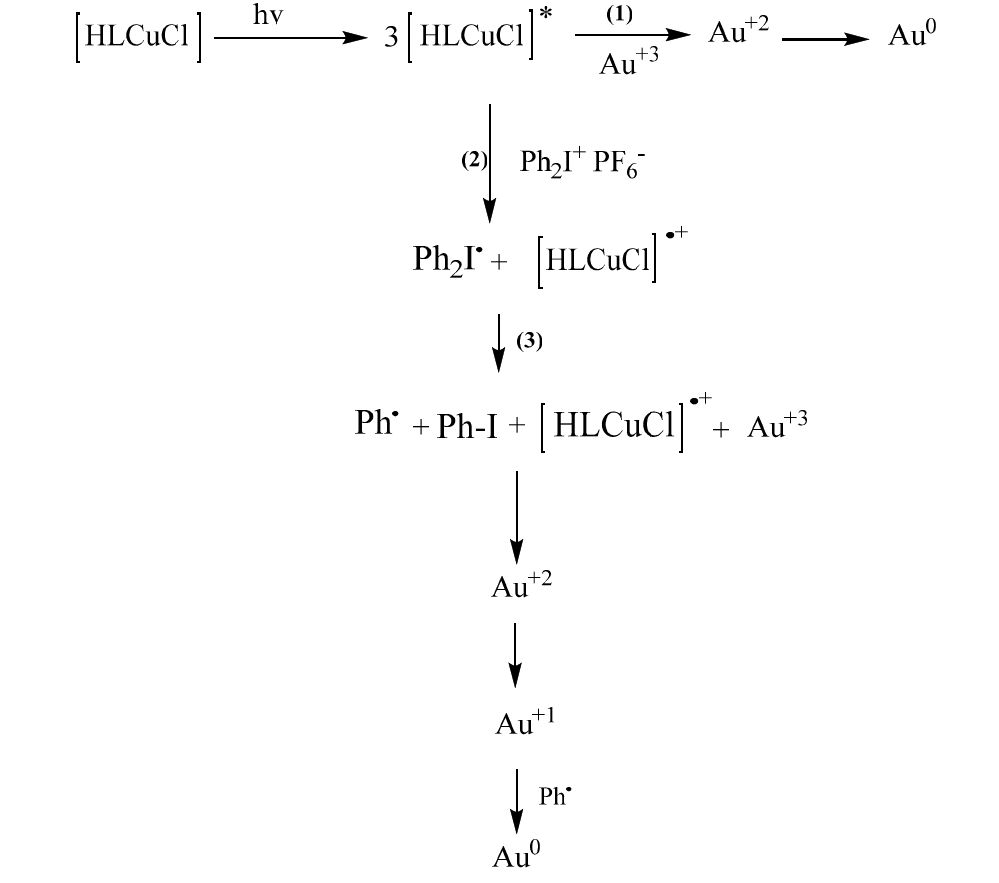
Scheme 6. Proposal mechanism of the system based on HLCuCl/Iod salt.